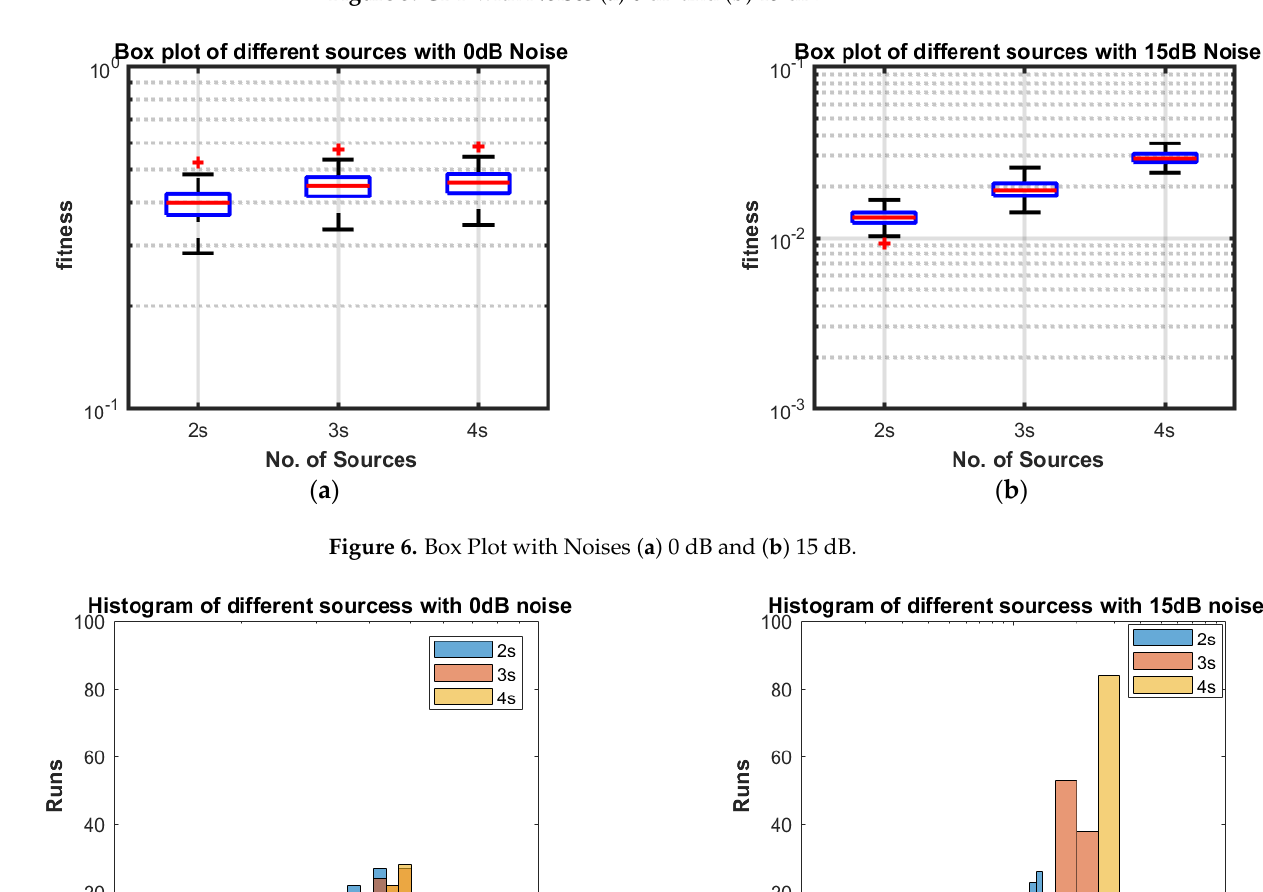
Figure 5. CDF with Noises ( a ) 0 dB and ( b ) 15 dB.